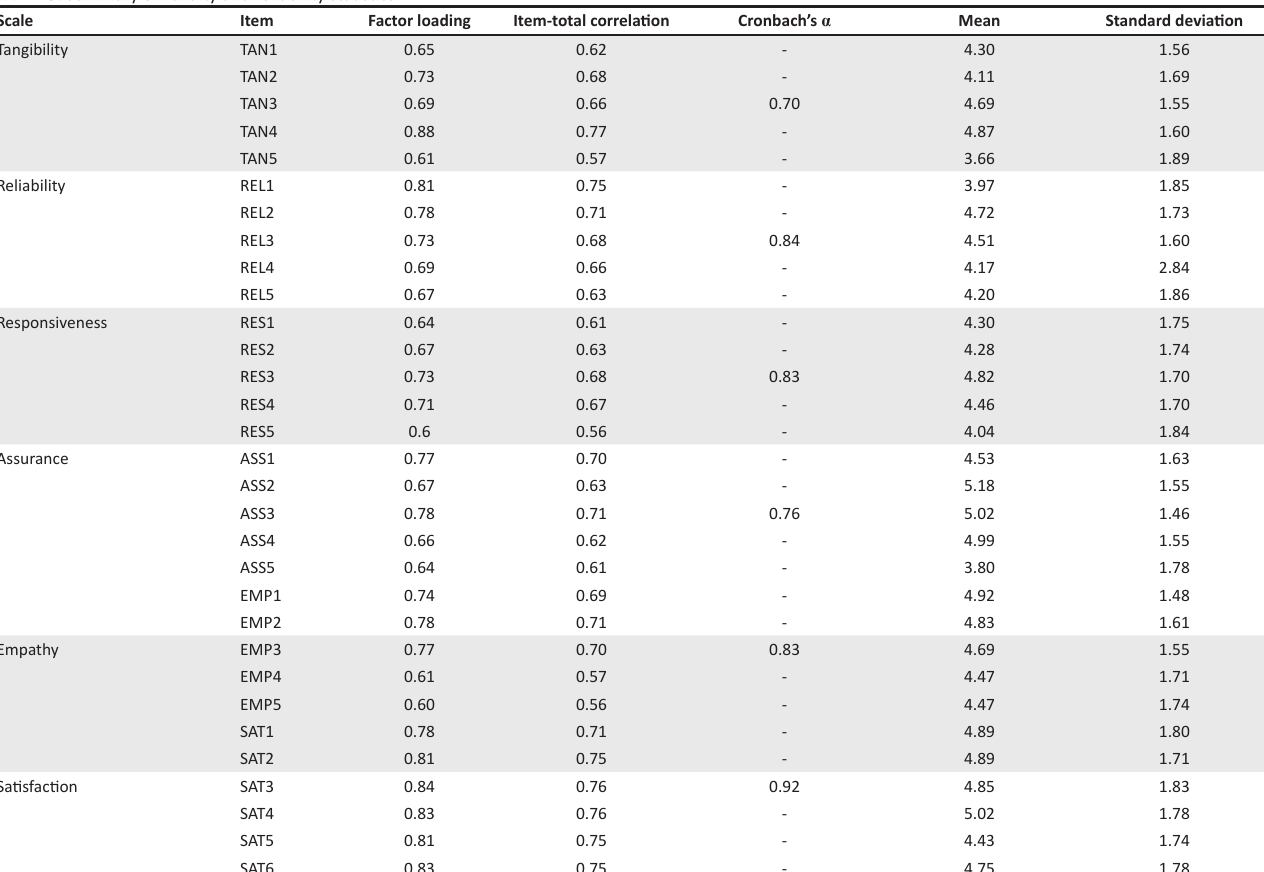
TABLE 3: Summary of validity and reliability statistics.